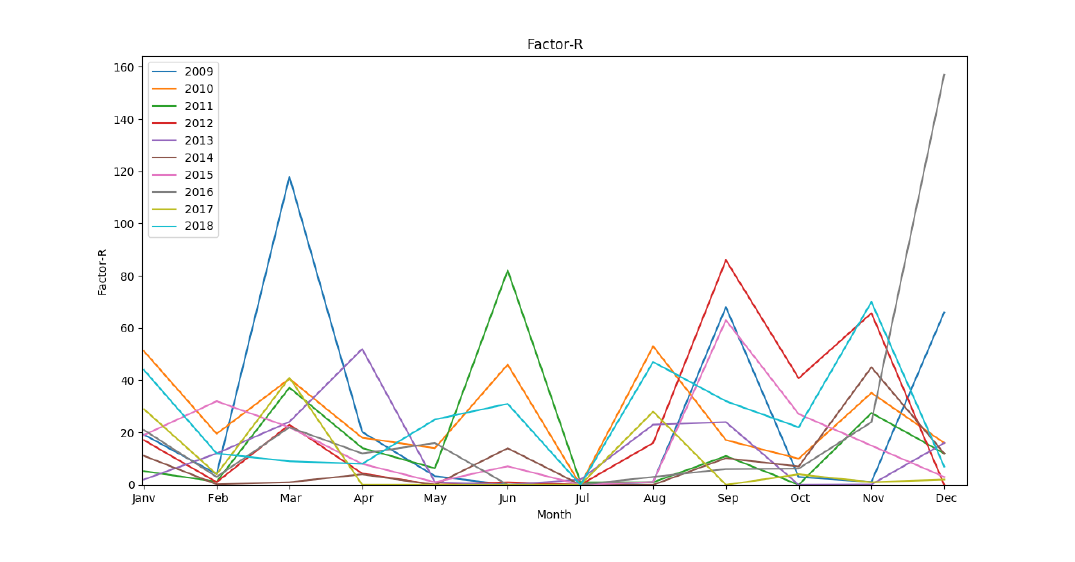
Figure 4. R-factor.